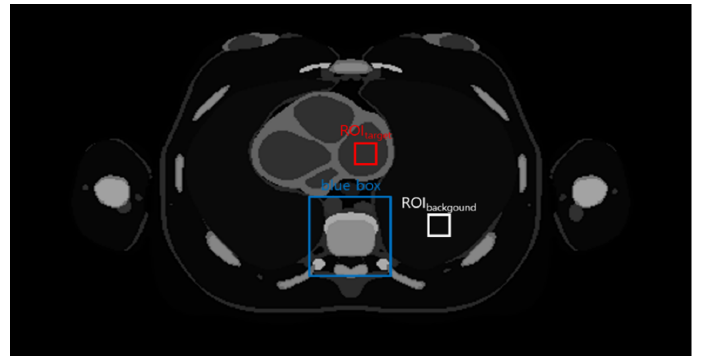
Figure 1. The image obtained from the male adult mesh (MASH) phantom. The region inside the blue box was magnified to compare the denoised images. Regions of interests (ROIs) were set to calculate the coefficient of variation (COV) and contrast to noise ratio (CNR) of the obtained chest image.